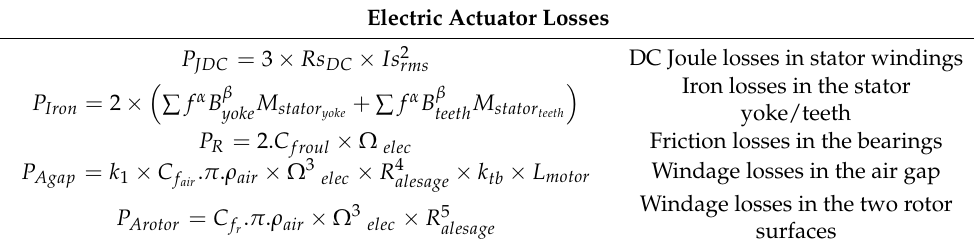
Table 10. Electric actuator losses computation